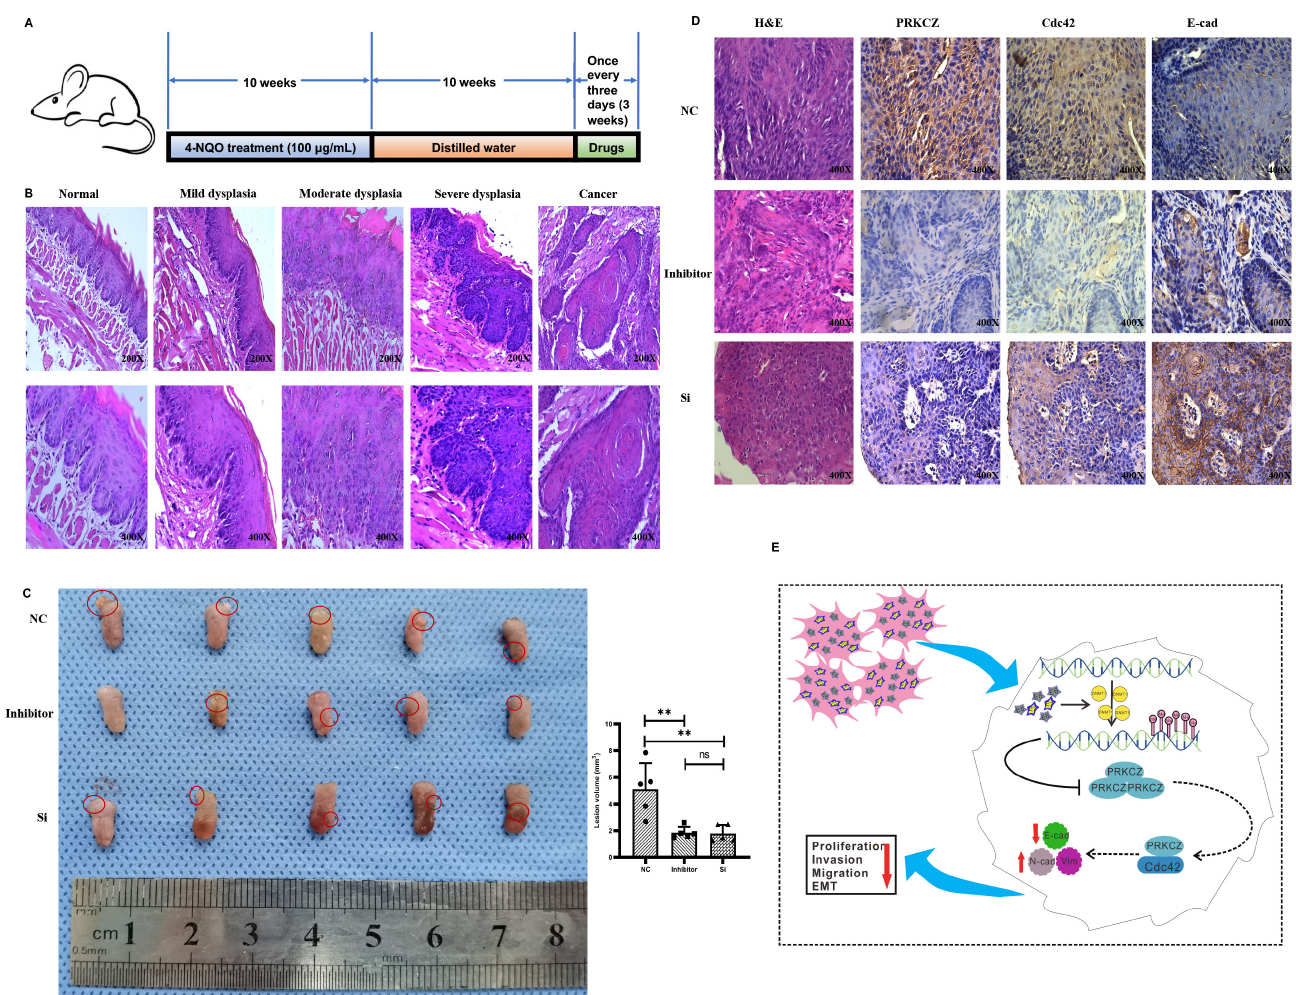
Figure 6. Blocking PRKCZ delayed the tumor growth of HPV16-E6/E7 transgenic mice. ( A ) Schematic diagram illustrated the mice feeding process. ( B ) Representative HE staining pictures of 4-NQO treated transgenic mice. ( C ) The tumor general views and volumes of three groups. ( D ) Representative IHC pictures of PRKCZ, Cdc42, and E-cadherin in three groups. Quantitative analysis based on triplicate experiments. ( E ) Schematic diagram illustrated that the role of PRKCZ hypermethylation in HPV+ HNSCC progression. Results were presented as means ± SD. ns > 0.05, ** p <